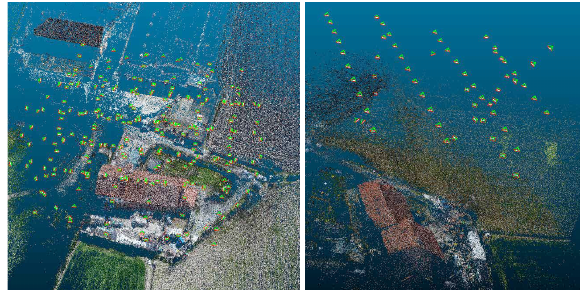
Figure 9 Camera pose of two oriented dataset using MicMAc (Phantom 4 left, Mavic